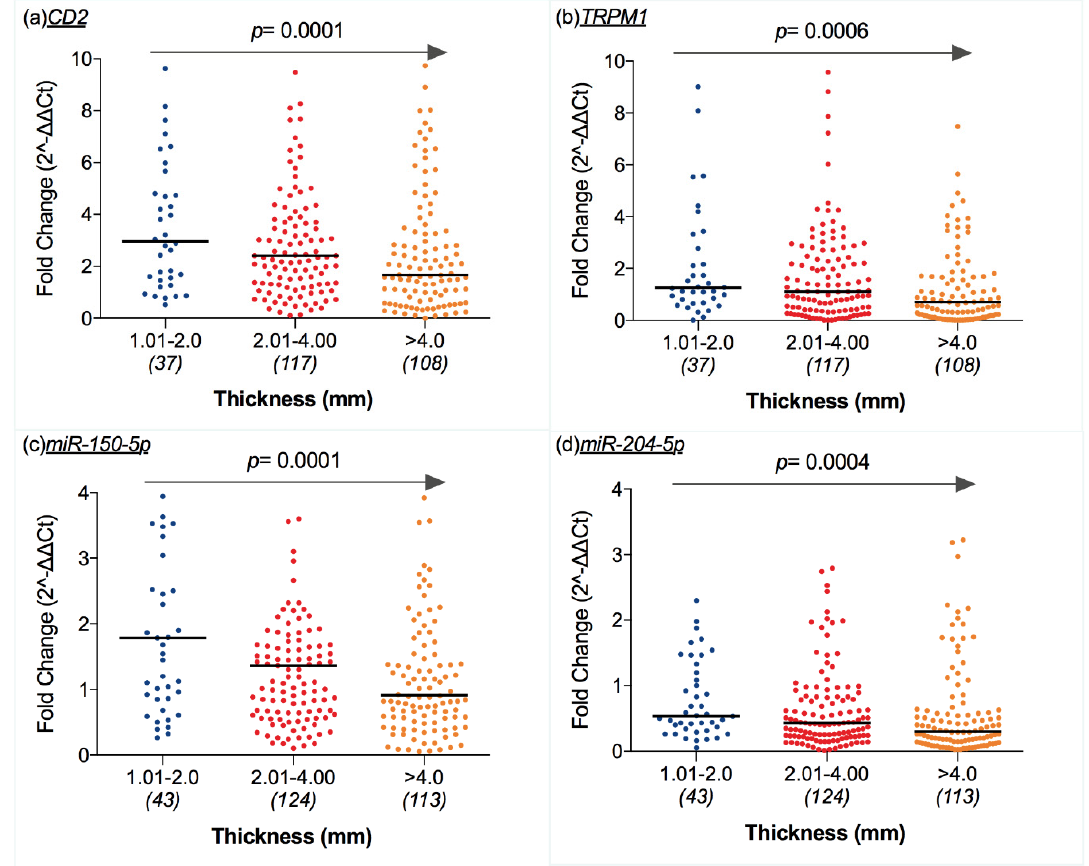
Figure 4. Scatter dot plots representing mRNA and miRNA expression levels (ratio of threshold cycles) were different according to CM thickness: ( a ) CD2 and ( b ) TRPM1 expression decreased as tumor thickness increased ( p = 0.0001 and p = 0.0006); similarly, ( c ) miR-150-5p and ( d ) and miR-204-5p were negatively correlated with tumor thickness ( p = 0.0001 and p = 0.0004). Middle lines refer to the median value ( p values on the graph refer to Spearman’s rank correlation test using Breslow’s depth as a continuous variable).